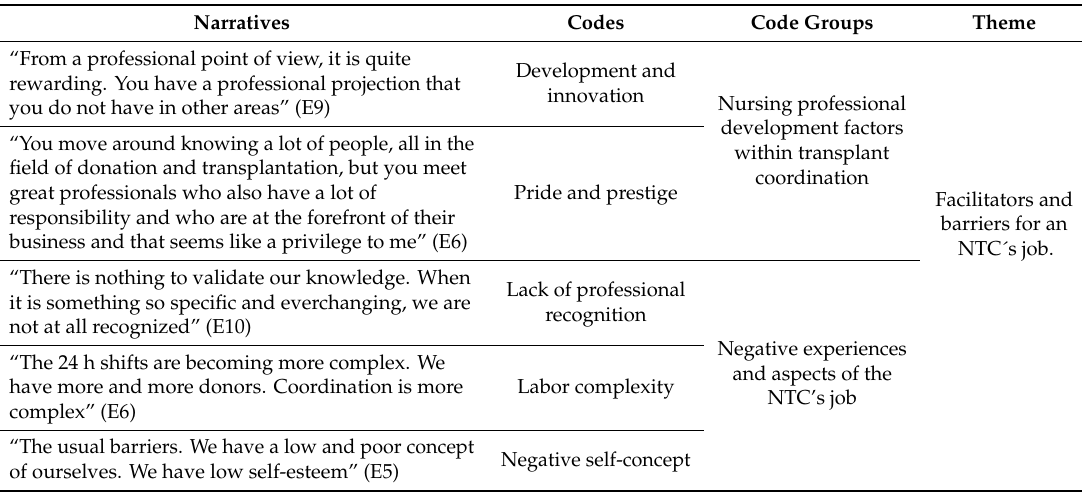
Table 2. Example of the inductive coding process analysis.